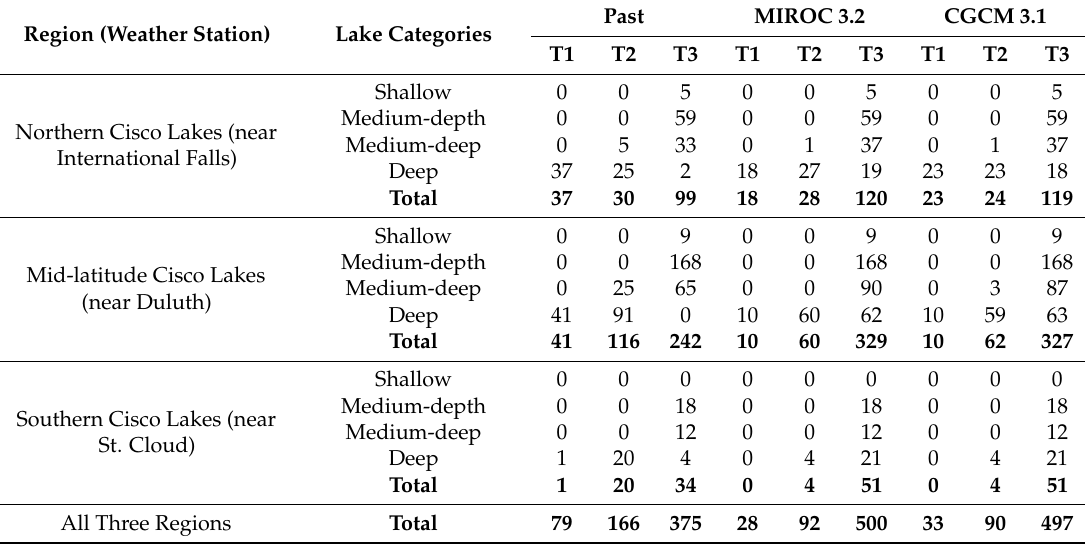
Table 7. Number of lakes selected as Tier 1 (T1) and Tier 2 (T2) refuge lakes and Tier 3 (T3) non-refuge lakes from the 620 cisco lakes grouped by maximum depth and latitude using AvgATDO3 VB contour lines derived from 12 shallow, 16 medium-depth, 24 medium-deep, and 30 deep virtual lakes, respectively. Three principle weather stations (International Falls, Duluth, and St. Cloud) were used for the simulations of cisco lakes associated with three geographic regions (range of latitudes) in Minnesota (Figure